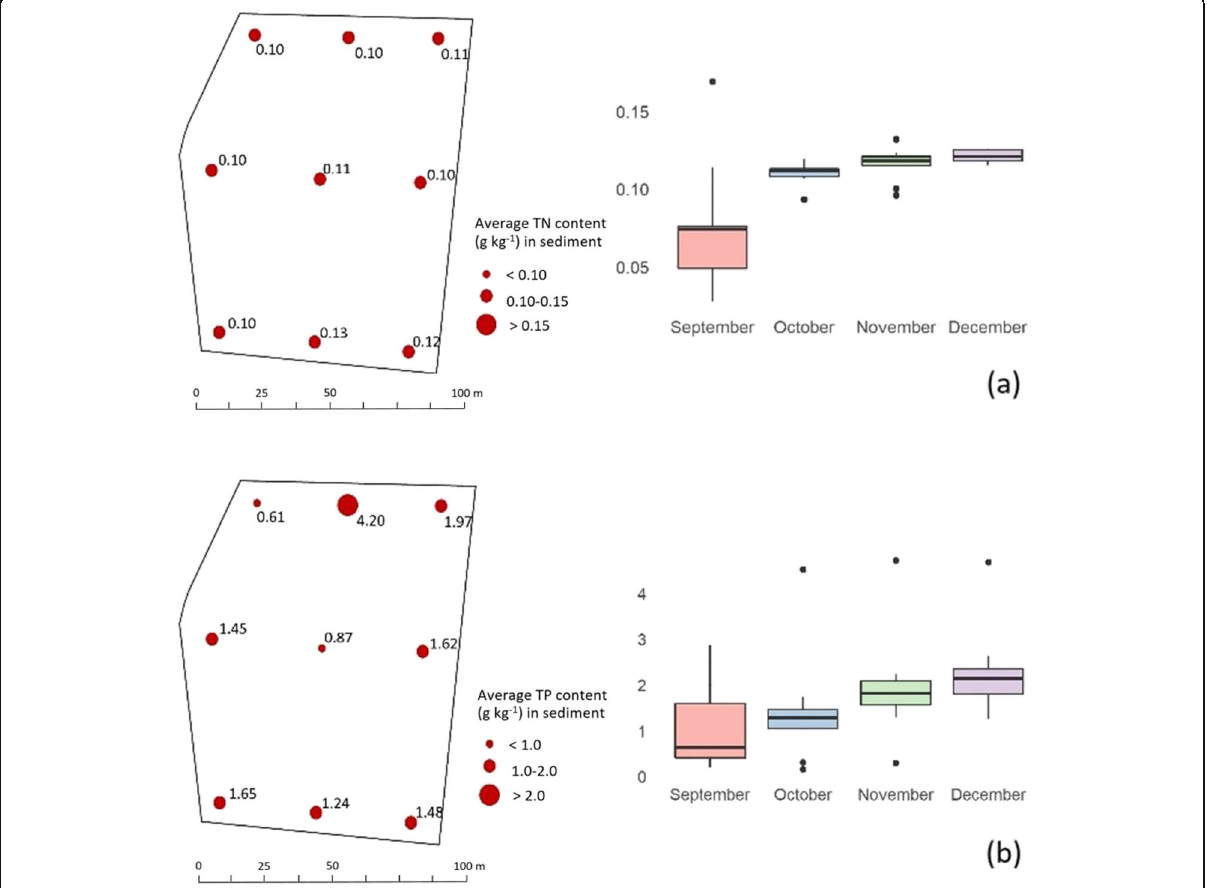
Fig. 3 Spatio-temporal variations of ( a ) total nitrogen and ( b ) total phosphorus in the sediment during a 90-d crop cycle. Graphical distribution maps present average nutrient values on each sampling location based on four times experiment. Boxplots demonstrates data distribution based on monthly